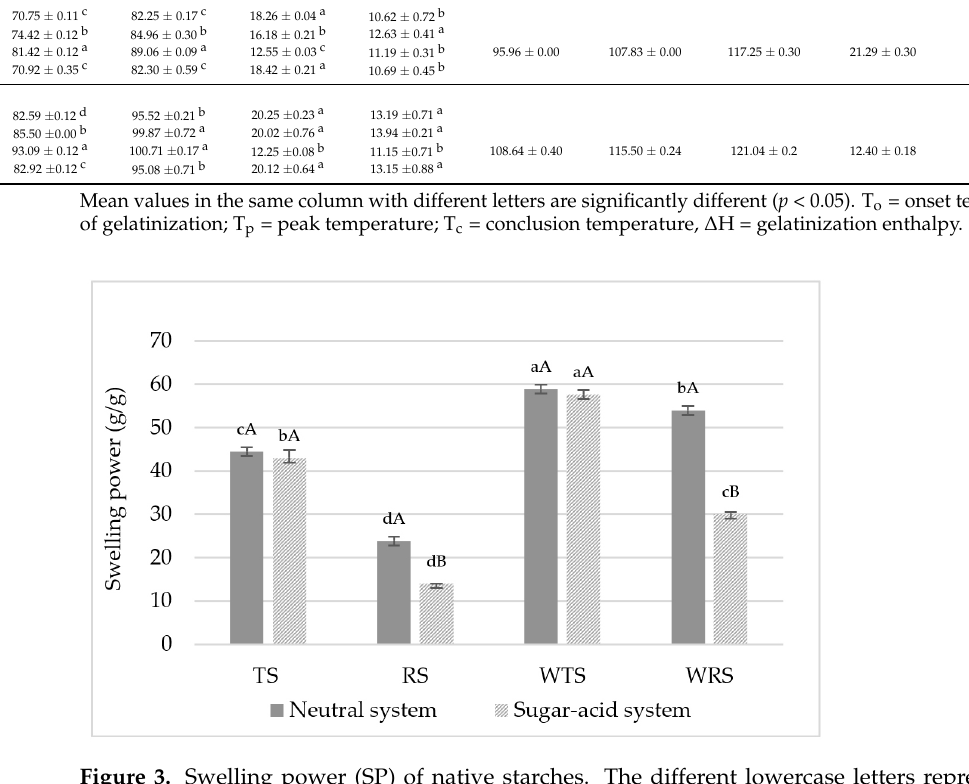
Figure 3. Swelling power (SP) of native starches. The different lowercase letters represented a significant difference ( p < 0.05) in values compared between types of starch in the same system. The different uppercase letters represented a significant difference ( p < 0.05) in values compared between systems.